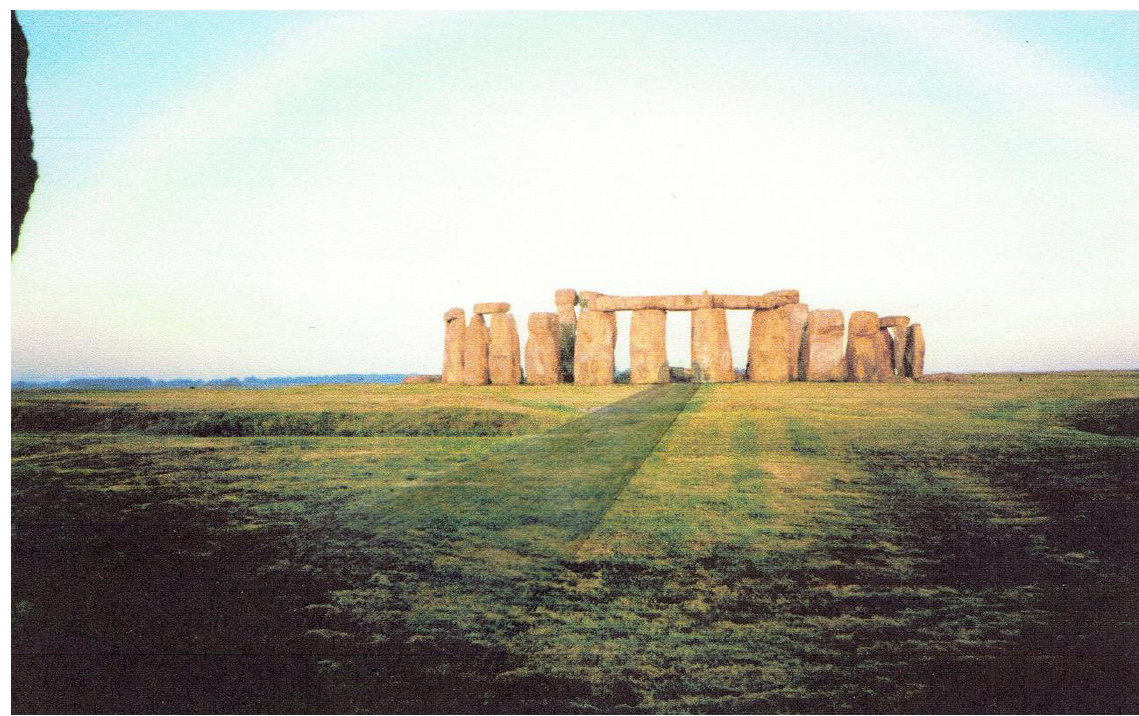
Figure 6. This photograph was taken a few minutes after sunrise on 19 June 1989 by the author standing on the Stonehenge axis. Shortly before this, the entire peak of the shadow was inside the monument between portal Stones 1 and 30. A little later as detumescence progresses and the shadow, now darker, moves to the right and is on its way out, a part is still inside while a part falls upon portal Stone